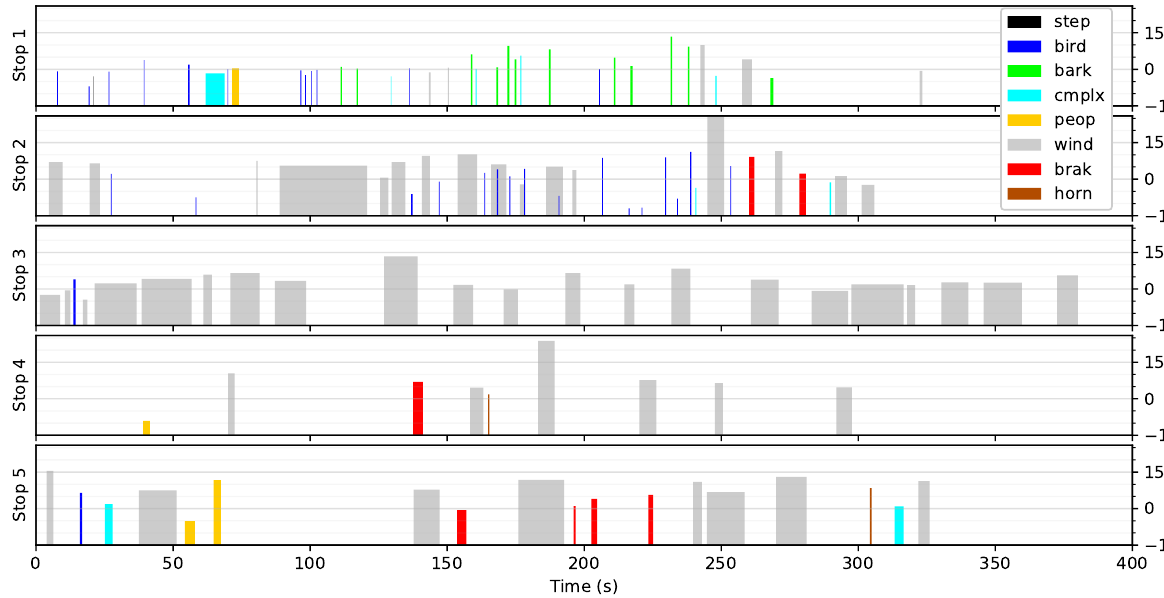
Figure 4: Events plot for each of the 5 stops during the recorded time.